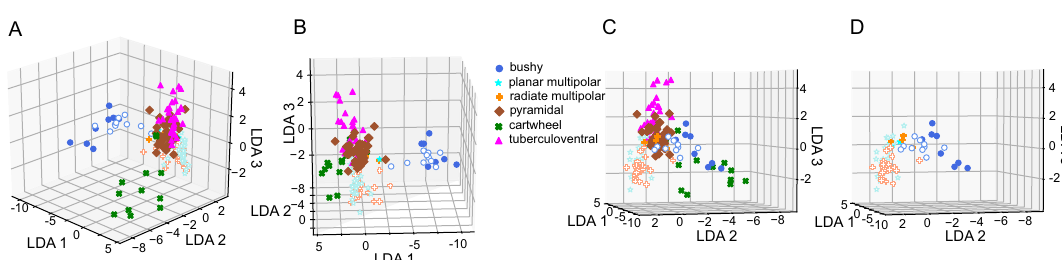
Fig 4. LDA with supervised clustering by cell morphology. A. The first 3 (largest) LDA components are shown in a perspective view. The axes represent the projections of each cell on to the 3 largest components from the standardized data (zero mean, unit standard deviation; therefore there are no units). Note the clear separation of the bushy cell and cartwheel cells populations from the rest of the CN neurons. Although the other populations are close together, they are also separated as can be appreciated by comparing the different views. Cells from CBA/CaJ mice are shown with open symbols; cells from the NF107 mice are shown with closed symbols. B, C. Two other perspective views (rotated) of the same data as in A. D. A view of the data for the VCN cells only (bushy, planar multipolar and radiate multipolar) for clarity. This is the same perspective view as panel C.